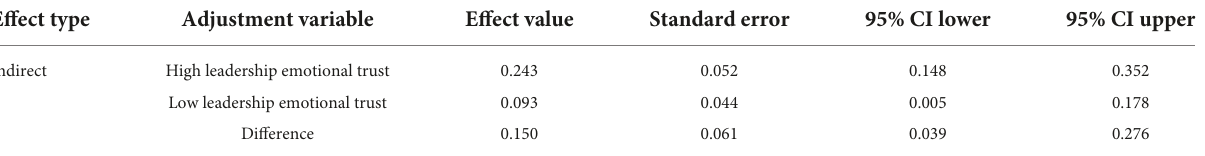
TABLE 5 Results of tests with moderated mediating effects.